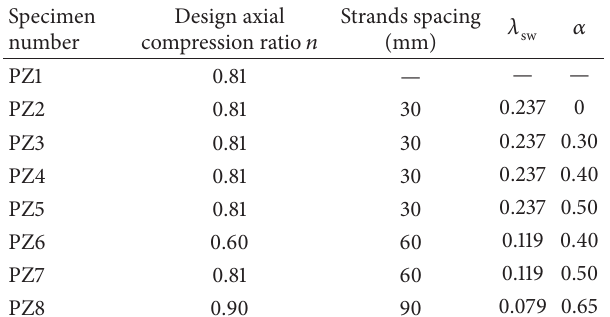
Figure 2: Circular columns prestressed with steel wires. Table 1: Test parameters.